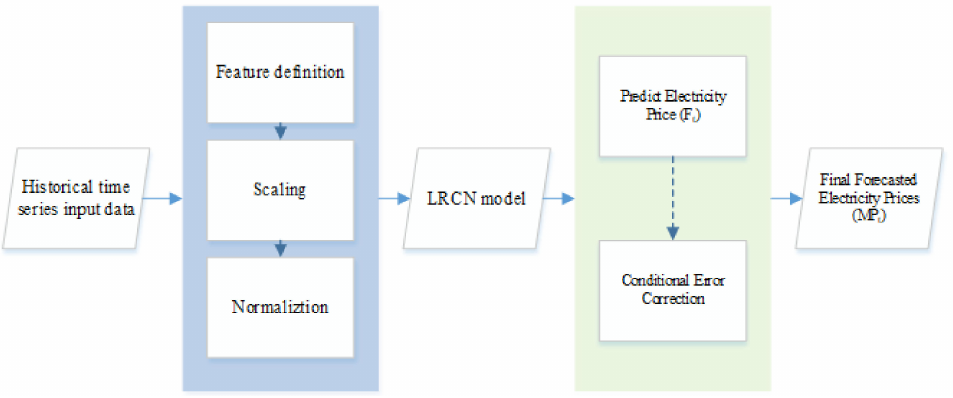
Figure 6. Flowchart of short-term electricity price forecasting with